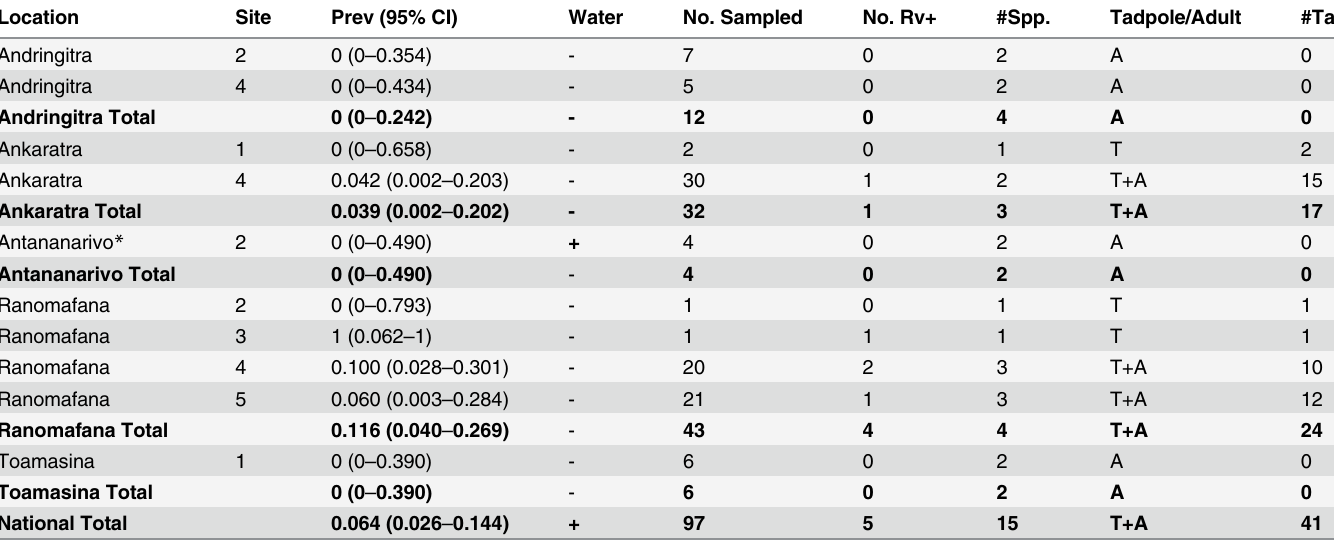
Table 3. Detection of ranavirus (RV) in Madagascar by quantitative PCR (qPCR) and apparent prevalence including 95% confidence limits (CL) for infection as per swab results, assuming qPCR sensitivity of. 80 as per Gray et al. (2012) and absolute specificity (1.0).